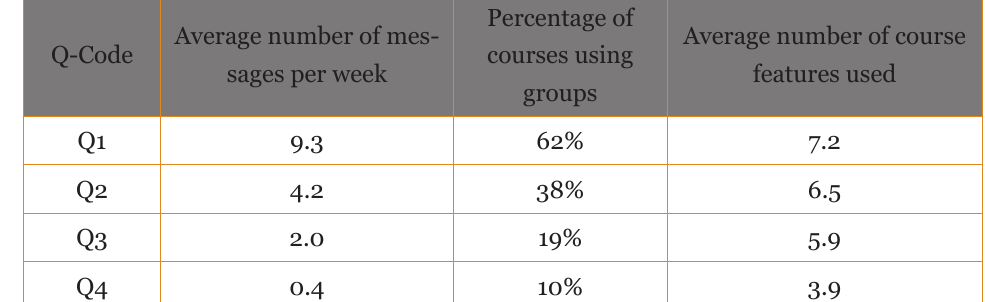
Q-Code Level of Interaction